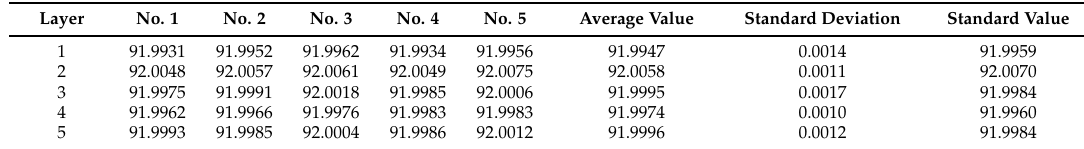
Table 3. Measuring data of Engine Block 2# (mm).